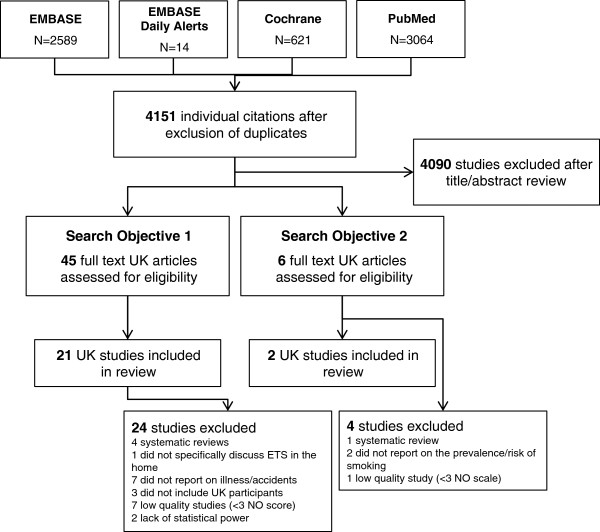
Flow diagram of included and excluded studies.